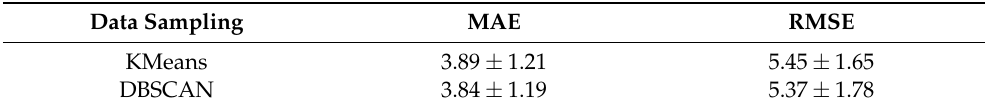
Table 2. MAE and RMSE for k-nearest neighbors broken down by the clustering method used for sampling the folds.